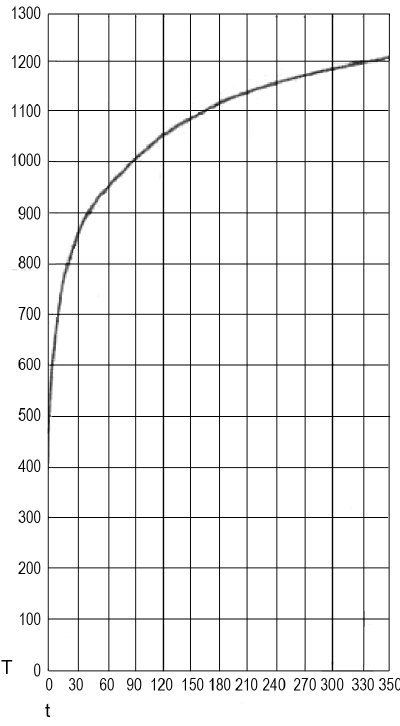
Fig. 4. Temperature and time curve The height and width of the wood samples was 210 mm and 150 mm respectively, the thickness varied from 47 mm to 59 mm (Fig. 5).